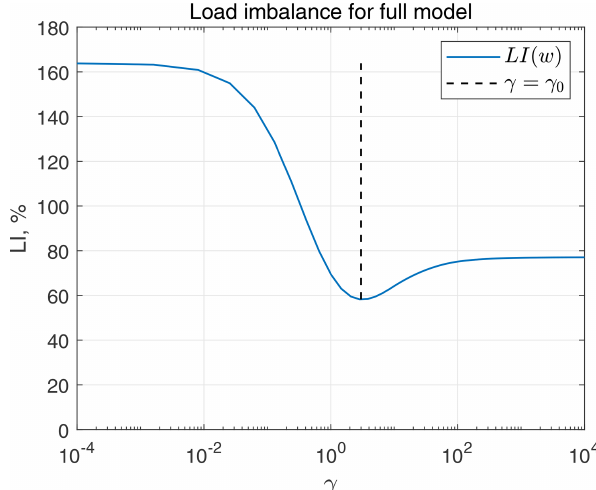
Figure B1. Load imbalance for the full model LI (w(γ)) , where w(γ) = w 2d + γw 3d ; γ 0 =